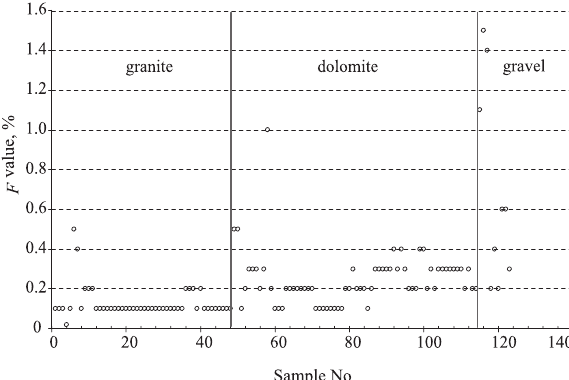
Fig. 1. F values of resistance to freezing and thawing of aggregates